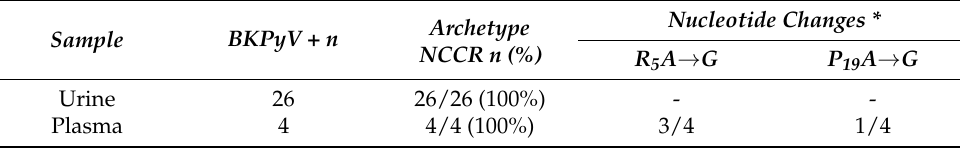
Table 9. Sequence analysis of BKPyV